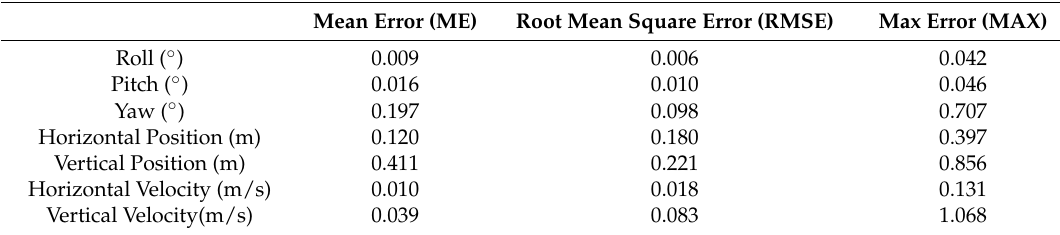
Table 2. Statistical analysis of position and attitude estimation error in Scheme 1.